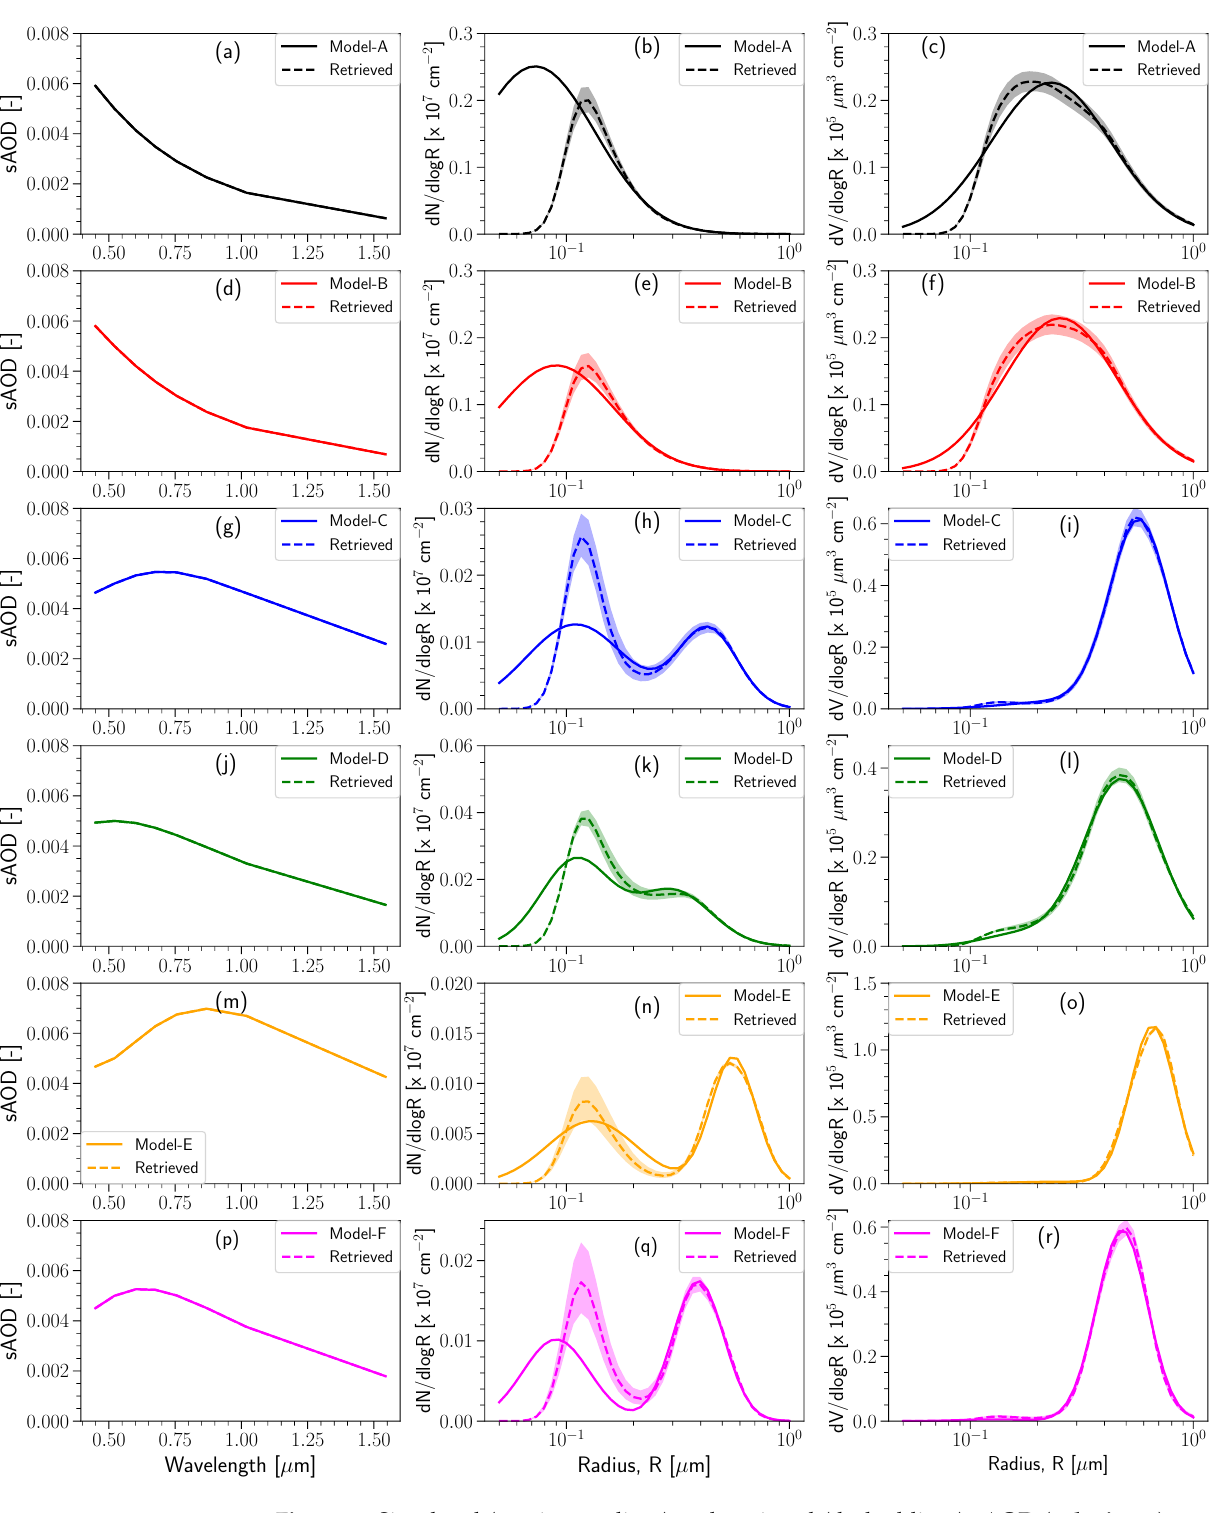
Figure 1. Simulated (continuous lines) and retrieved (dashed lines) sAOD ( a , d , g , j , m , p ), number ( b , e , h , k , n , q ), and volume ( c , f , i , l , o , r ) size distributions for models A, B, C, D, E, and F in Table 1. The shaded areas around the dashed lines denote the retrieval errors. The retrieved size distributions (number and volume) correspond to sAOD (at 521 nm) of 0.005 for all models A to